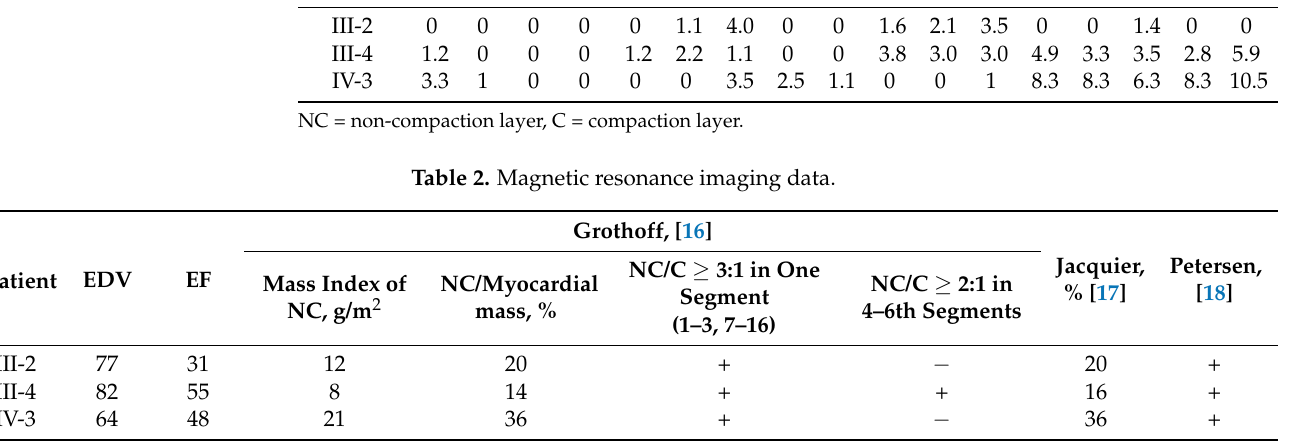
Figure 2. ( A – C ) Proband’s (III-4) cardiac magnetic resonance imaging in movie mode, steady-state free-precession (SSFP) sequence: ( A ) long axis 2–chamber projection, ( B ) long axis 4–chamber